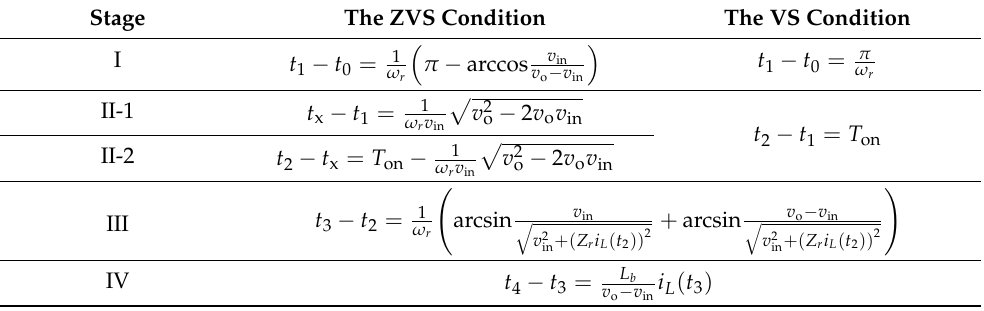
Table 2. Lists of the time intervals during the switching cycle.